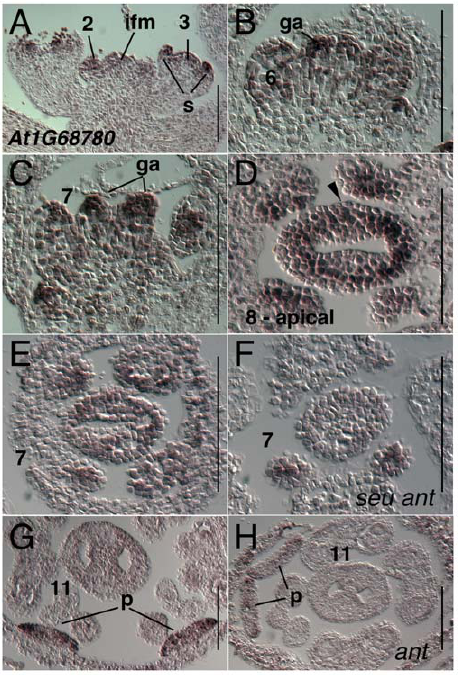
Figure 15. Results of in situ hybridization with At1G68780 antisense probe. Panels A–C show longitudinal tissue sections; panels D-H show transverse (cross) sections. Numbers indicate floral stages. Arrowhead indicates medial domain expression. s - sepal primordia; p - petal primordia; ga - gynoecial apex; ifm - inflorescence meristem. Scale bars in all panels are 100 microns. All panels are Col-0 wild type except as noted.